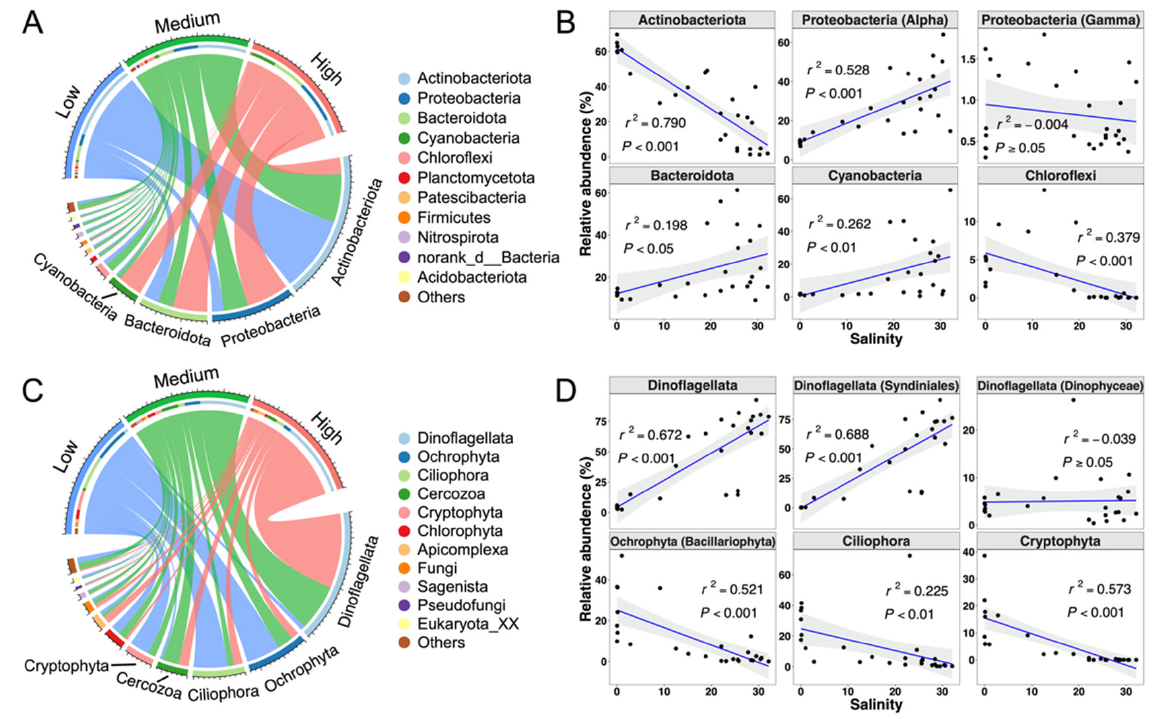
Figure 6. The chord diagrams indicate the mean relative abundance of bacteria ( A ) and protists ( C ) at the phylum level of the low-salinity cluster, medium-salinity cluster and high-salinity cluster. Scatter plots display the relative abundance of some representative phyla (class) of bacteria ( B ) and protists ( D ) as a function of salinity. The blue line is the linear regression fit and the shaded area is the 95% confidence interval. r 2 and p represent the goodness of fit and significance, respectively.